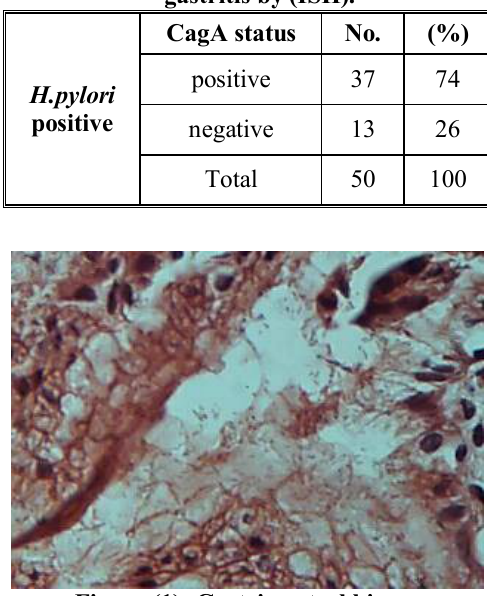
Figure (1): Gastric antral biopsy specimen from stomach infected with H.pylori that appear curved or round (Giemza stain) (100X).